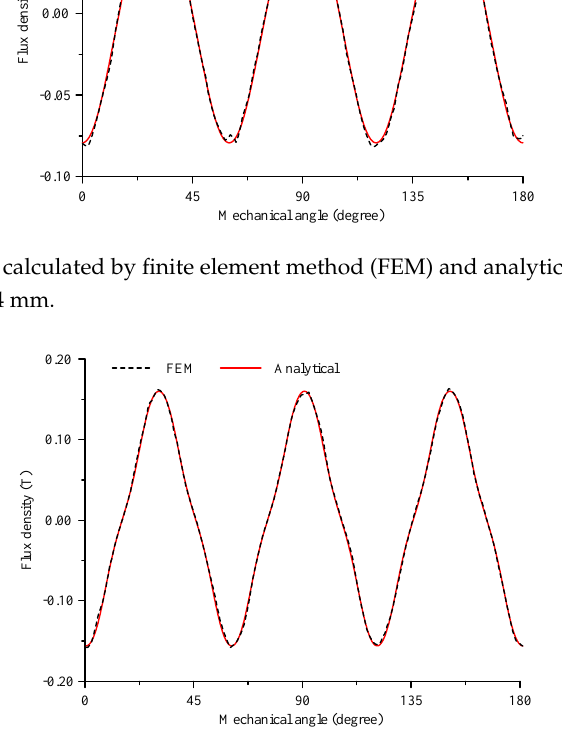
Figure 6. Flux density calculated by FEM and analytical model through the coils at the radius of 24 mm. Figure 7 presents the magnitude of the magnetic flux through coils varying with main dimensional parameters including the airgap length, the magnet thickness, the magnet length, and the coil position. It can be observed that the flux magnitude decreases with the increase of the airgap length. In general, a small airgap length is beneficial to electromagnetic energy conversion as well as power density, but it gives rise to challenges with device fabrication. Therefore, in the prototype ’ s design the airgap length is 1.5 mm, which is a tradeoff between power density and fabrication difficulty. The flux magnitude increases and tends to be saturated with the increase of the magnet thickness and the magnet length. To avoid waste of magnetic material, the thickness and the length are chosen as 3 mm and 10 mm respectively in this work. The figure also shows that the flux magnitude is maximized when the coil position locates at the radius of 19 mm.